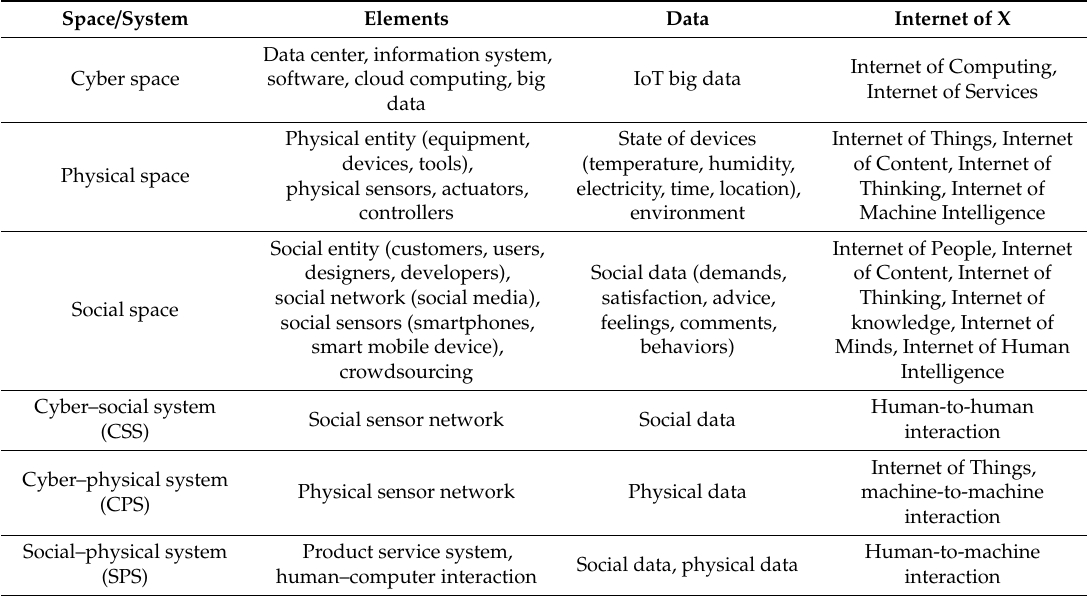
Table 4. The components of